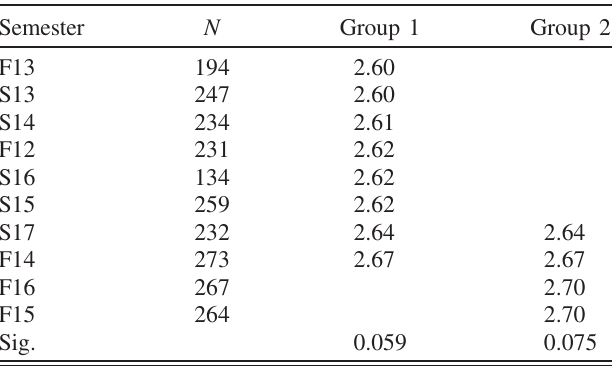
TABLE XIII. Duncan post hoc results on pretest